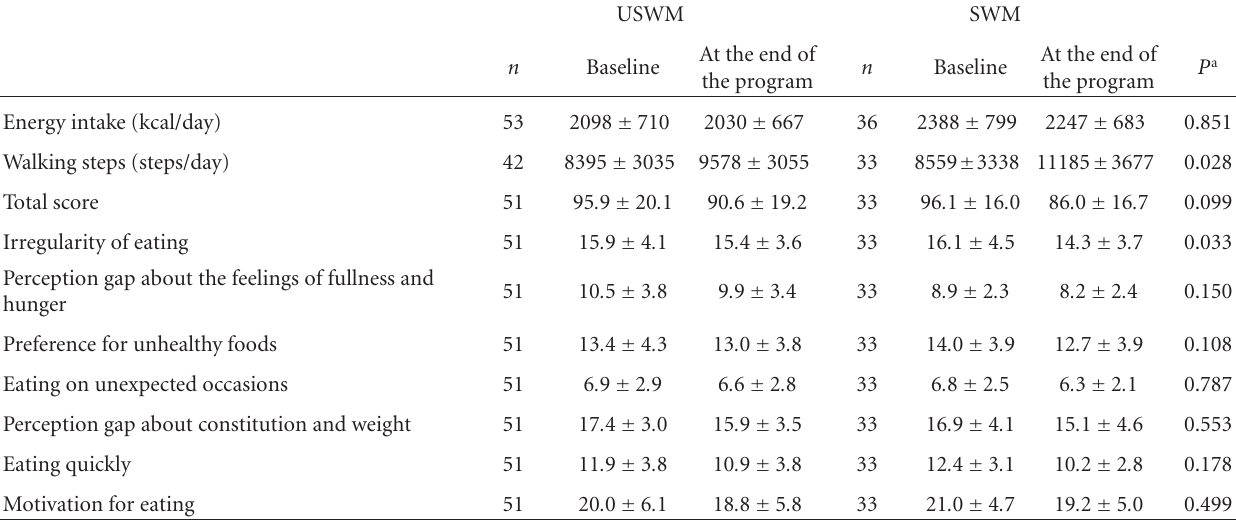
Table 2: Changes in energy intake, the number of steps walked per day, and the scores for eating behavior in successful weight maintainers and unsuccessful weight